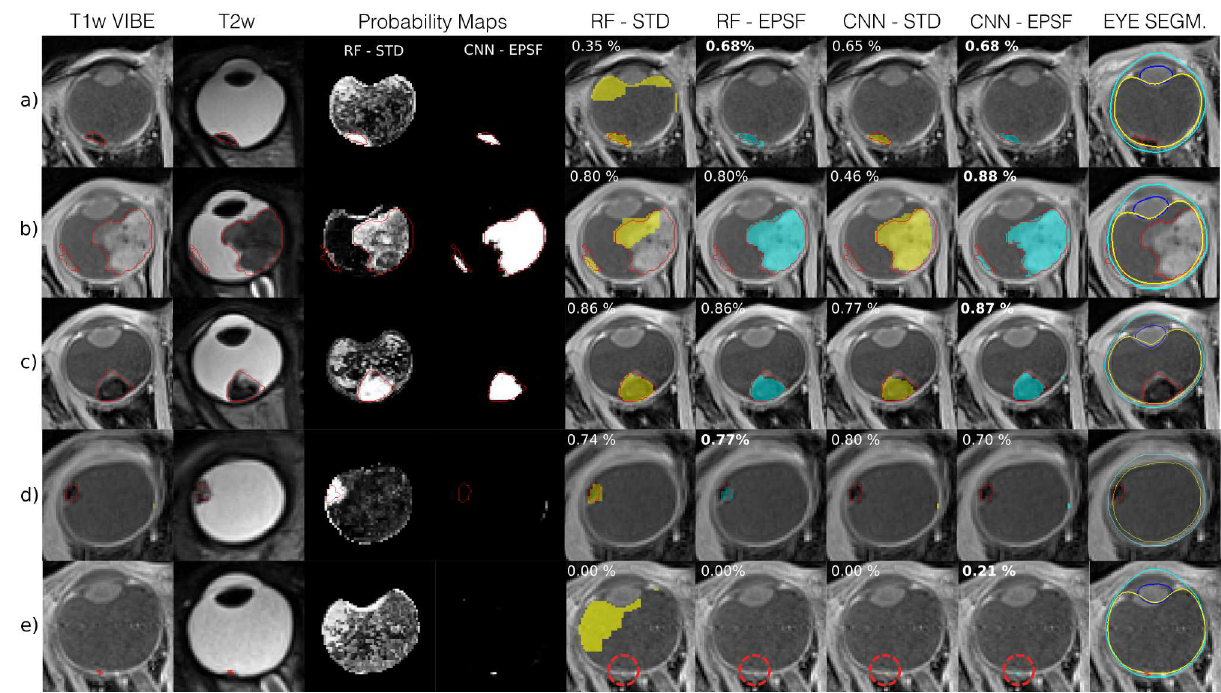
Fig 6. Example segmentation results. the tumor groundtruth is delineatedin red. ProbabilityMaps, P ( f i | Y i ), for worst (RF-STD) and best (CNN-EPSF) scenarios.Final column shows the pathological model (PM) eye segmentation results.